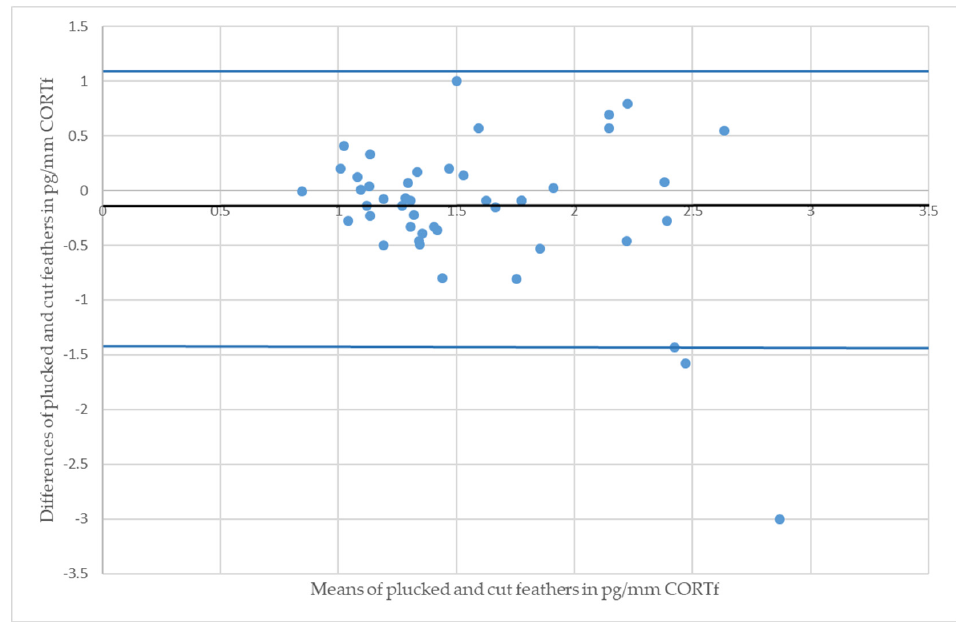
Figure 3. Bland-Altman plot of Mallards ( Anas platyrhynchos ); the residual plot displays the differences ( y -axis) against the means of values ( x -axis) of CORTf in the two sampling methods. The blue horizontal lines represent the mean difference ± 2 SD (mean = − 0.16, SD = 0.65).